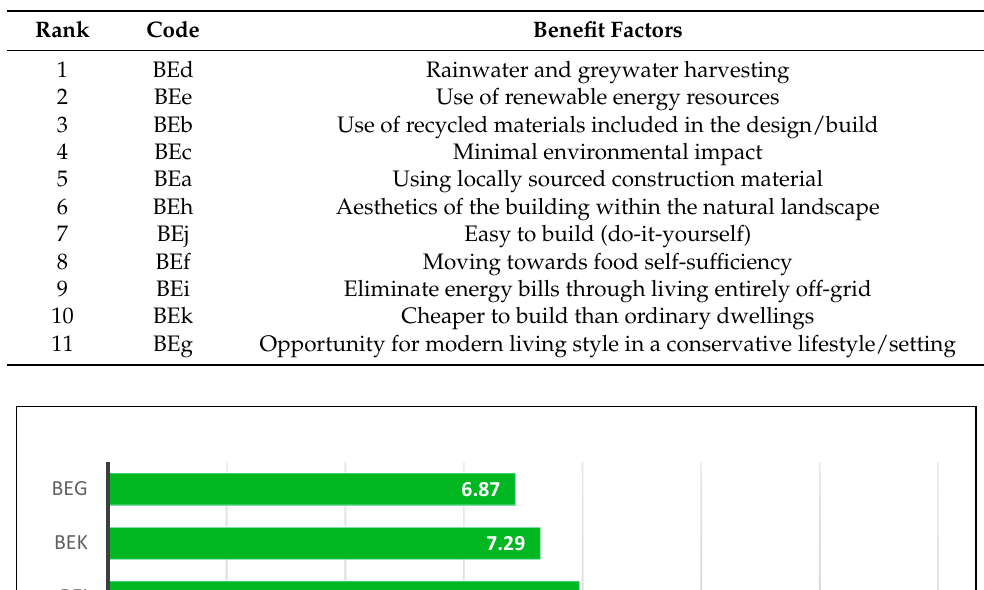
Table 4. List of beneficial factors in ranked order.